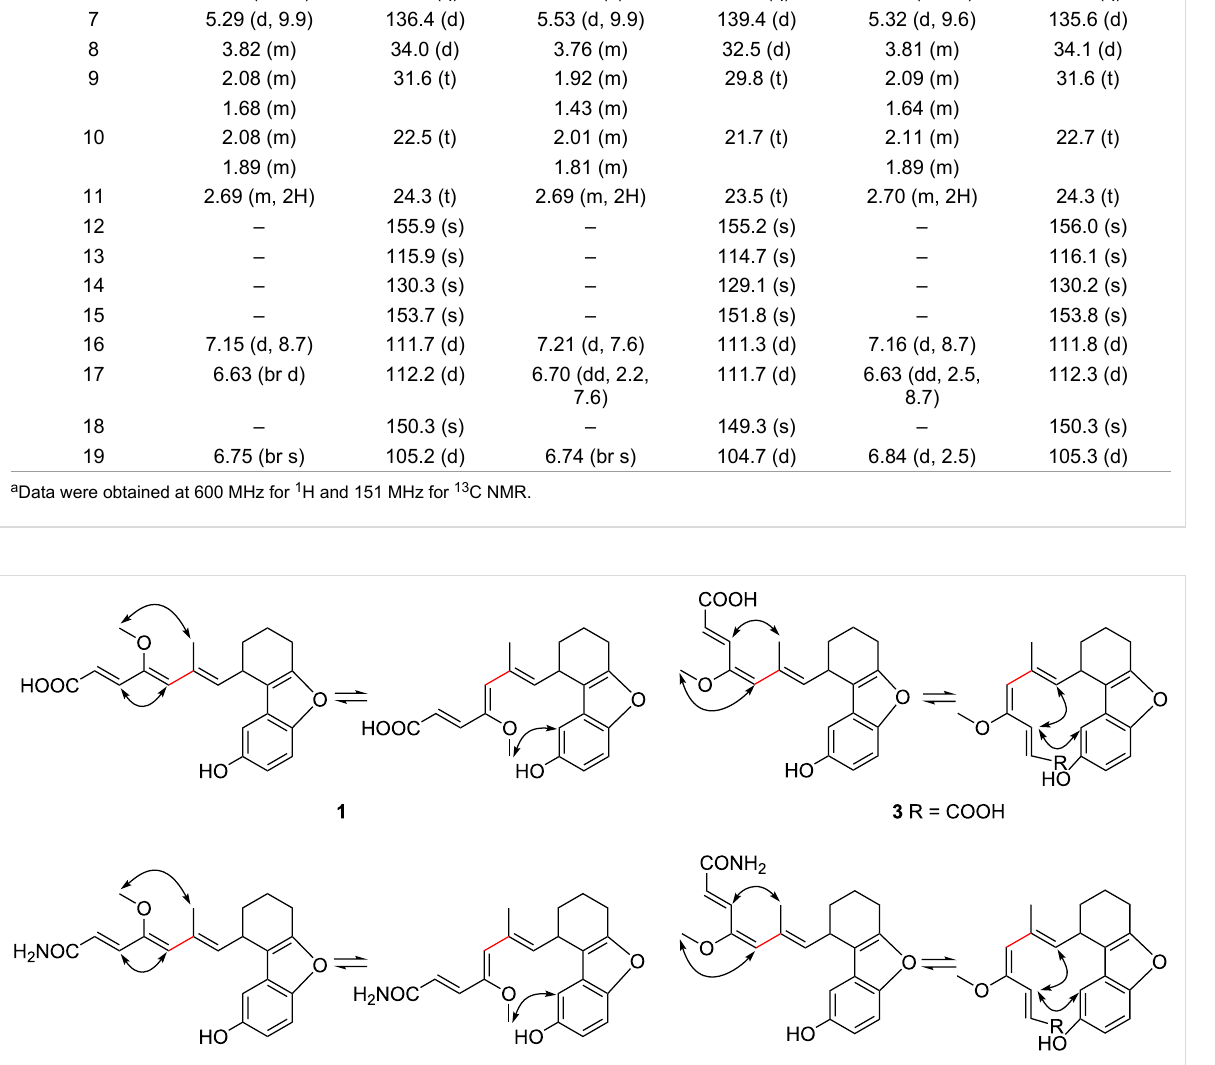
verticillioides strain S68 and Rhizoctonia solani strain GXE4 at 30 μ g/disc. Interestingly, cuevaenes D ( 4 ) and E ( 5 ) showed no inhibitory activity against all tested microbes at 30 μ